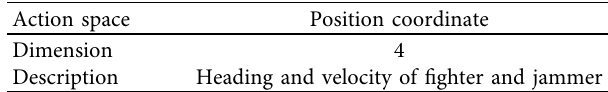
Table 4: Action-space